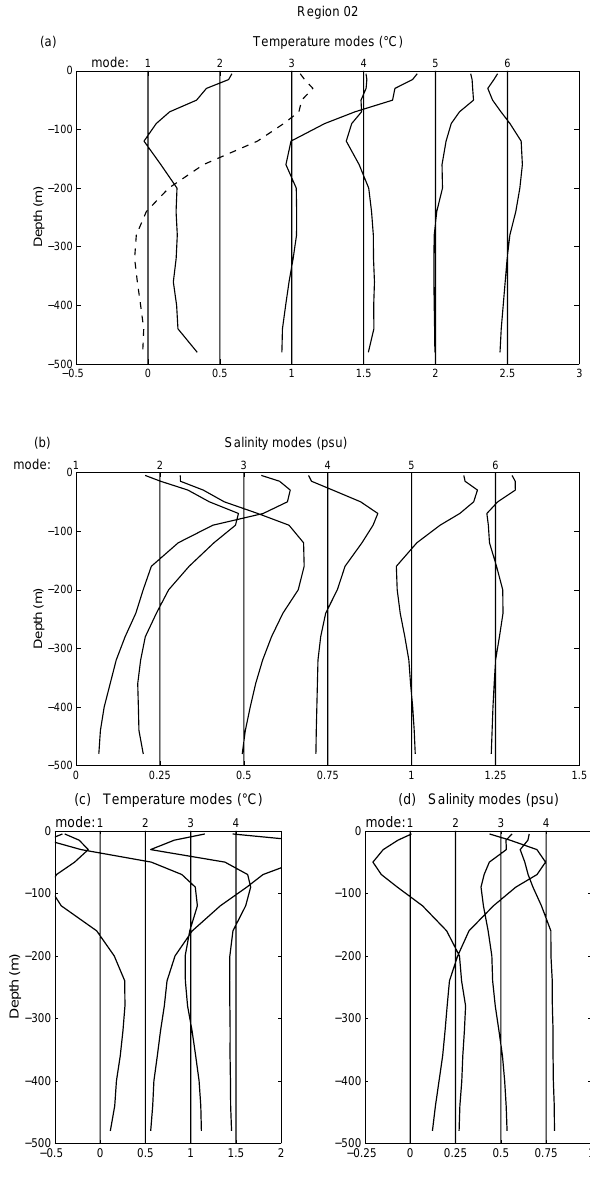
Fig. 6. Vertical EOFs for region 2 (Algerian Basin): (a) tempera- ture and (b) salinity modes in winter, and (c) temperature and (d) salinity modes in summer. The first six winter modes and four sum- mer modes are shown. For graphical convenience, a dashed line is used to indicate a change in sign, and respective offsets of 0.5 ◦ C and 0.25psu have been added to each T and S mode for ease of